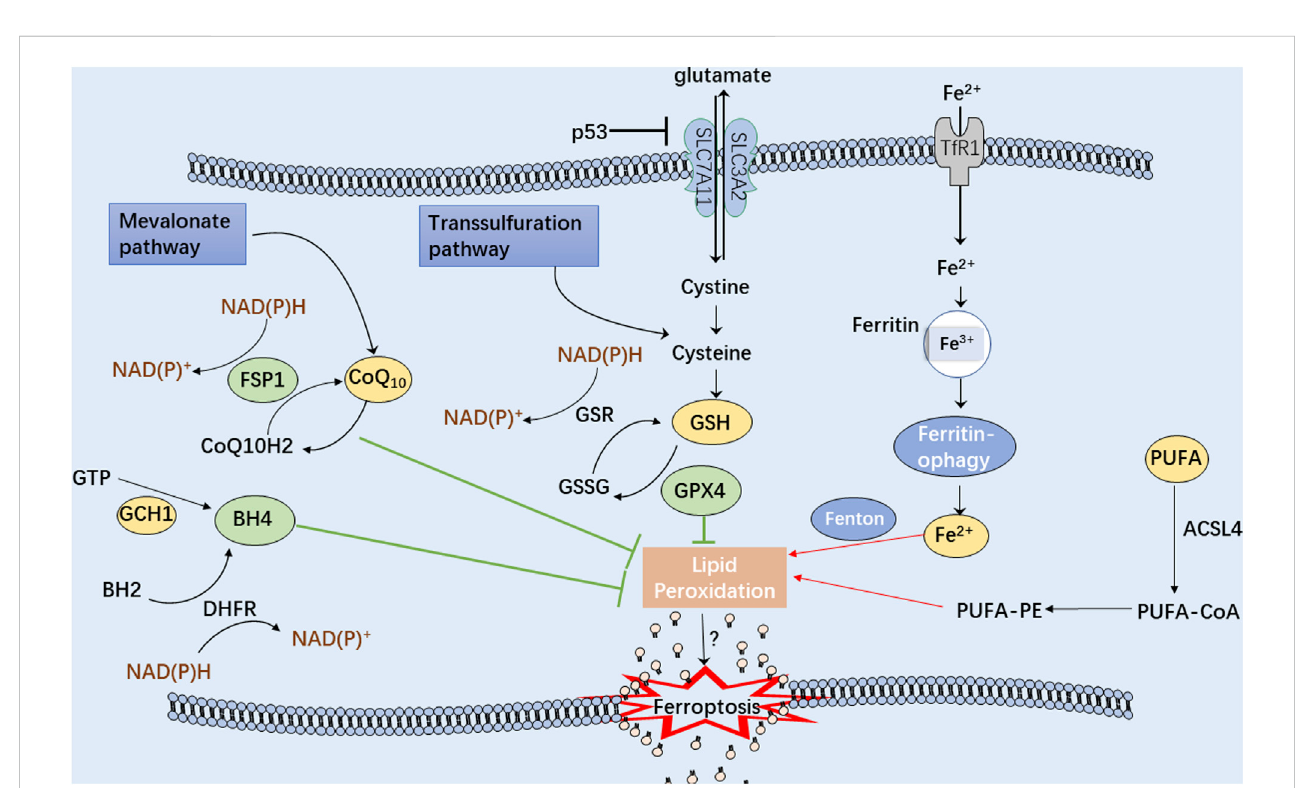
FIGURE 2 A schematic illustration showing the main mechanisms of the ferroptosis process. The green arrows represent three antioxidant systems: Xc-GSH- GPX4 pathway, FSP1-CoQ10-NAD(P)H pathway, and GCH1-BH4 pathway. Iron metabolism disturbance and polyunsaturated fatty acids (PUFA) peroxidation, marked with red arrows, signi fi cantly contribute to cellular